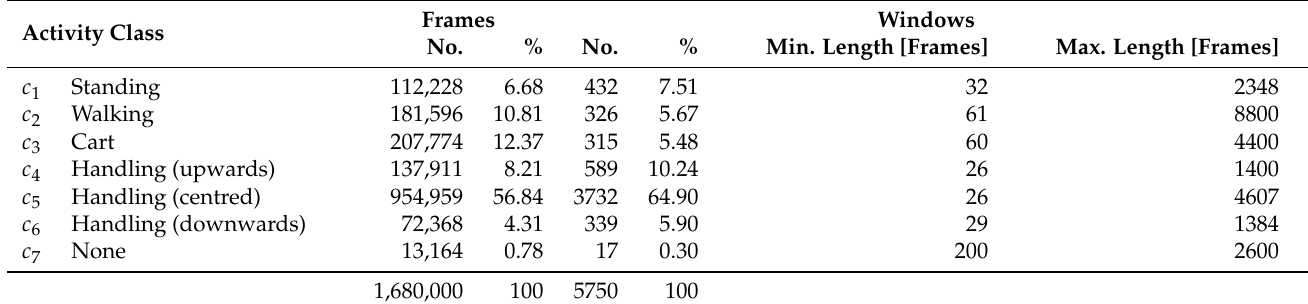
Table 3. Annotation results divided by activity